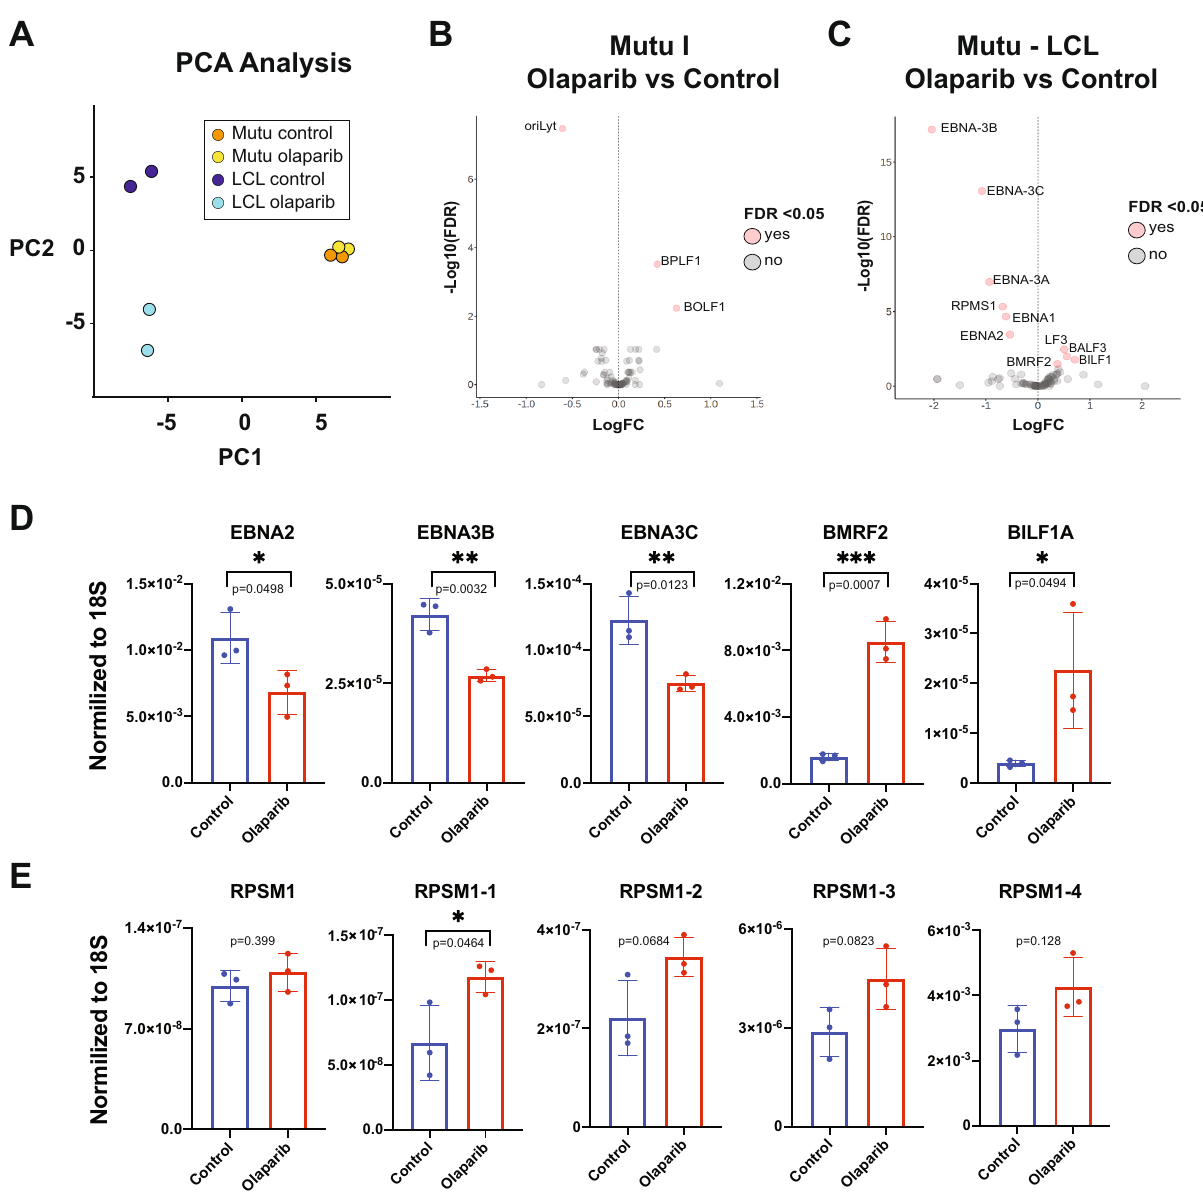
Fig. 2 Viral gene expression is dysregulated after PARP inhibition. A Principal component analysis (PCA) separating type I EBV latency (Mutu) and type III EBV latency (LCL) human B-cells by treatment (control or 2.5 µ M olaparib). Data derived from RNA-seq dataset utilizing biological duplicates. B Volcano plot illustrating dysregulated gene expression after olaparib treatment in Mutu cell line, with the left of the dashed line representing genes downregulated after PARP inhibition and the right representing genes upregulated after PARP inhibition. Genes displayed are dysregulated at p < 0.05 and FDR < 0.05. Genes with 2-fold change and q < 0.01 after correction for multiple testing (FDR) were considered as signi fi cantly differentially expressed. C Volcano plot illustrating dysregulated gene expression after olaparib treatment in LCL, as described in ( B ). Genes with 2-fold change and q < 0.01 after correction for multiple testing (FDR) were considered as signi fi cantly differentially expressed. D RT-qPCR validation of genes shown to be dysregulated by RNA-seq in LCL after PARP inhibition. Bar graph represents the average expression of three biological duplicates per treatment, each normalized to 18S expression, respectively. ( N = 3, mean ± SD). Groups were compared by paired student ’ s t test assuming equal variance (two-tailed). (* = p ≤ 0.05, ** = p ≤ 0.01, *** p = ≤ 0.001) Source data are provided as a Source Data fi le. E RT-qPCR validation of RPMS1 expression using fi ve separate primer sets, spanning various exons in the gene. Source data are provided as a Source Data fi le. The bar graph represents the average expression of three biological replicates per treatment ( N = 3, mean ± SD). Groups were compared by paired student ’ s t test assuming equal variance (two-tailed). (* = p ≤ 0.05, ** = p ≤ 0.01, *** p = ≤